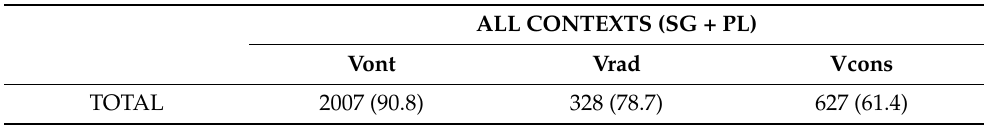
Table 5. Total number of correctly agreeing verb forms in the three different agreement patterns Vont, Vrad and Vcons (proportions within